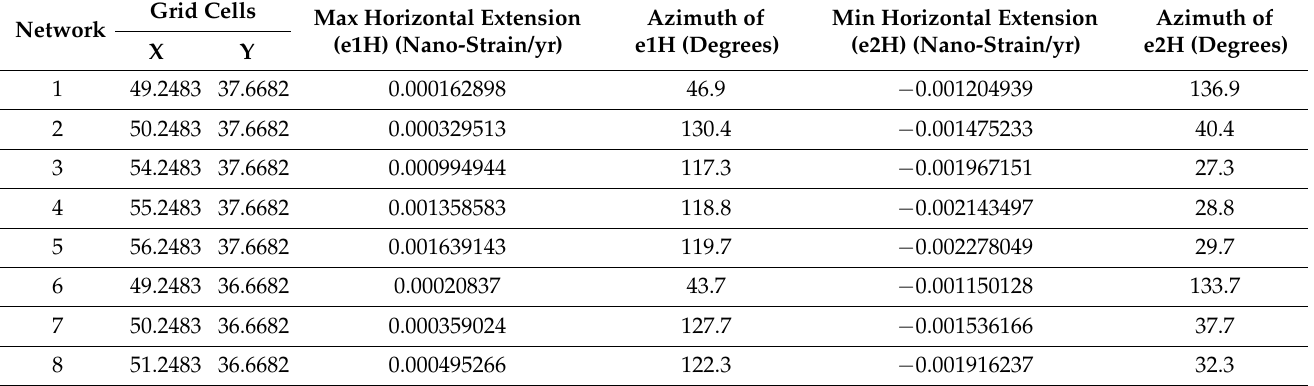
Table 6. The min and max horizontal extension values with their azimuths (geodetic strain